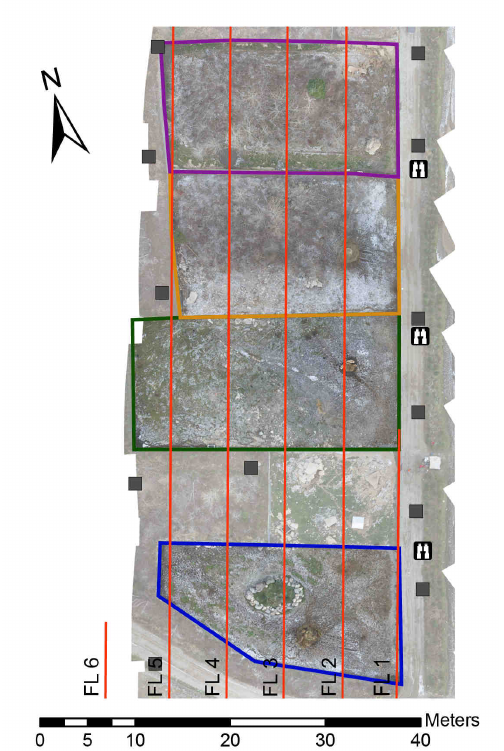
Figure 1. Study area: Enclosures at the Falardeau Wildlife Observation and Agricultural Interpretive Centre in Saint-